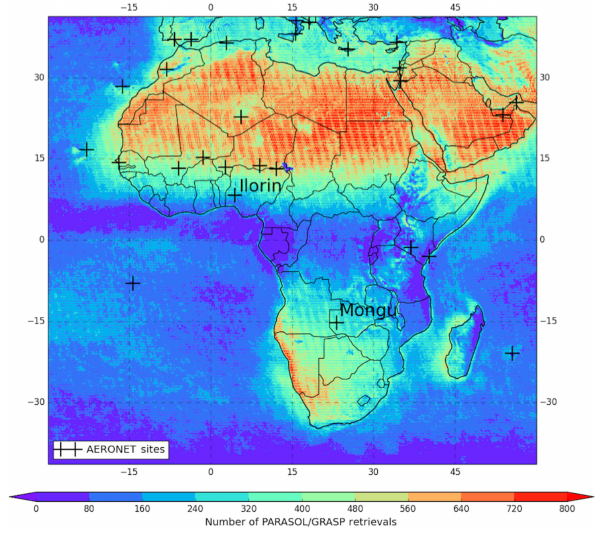
Figure 1. Distribution of PARASOL/GRASP AOD retrievals per 0.1 ◦ × 0.1 ◦ grid cell over a year (December 2007 to November 2008); the 28 AERONET sites used for validation are also shown with black